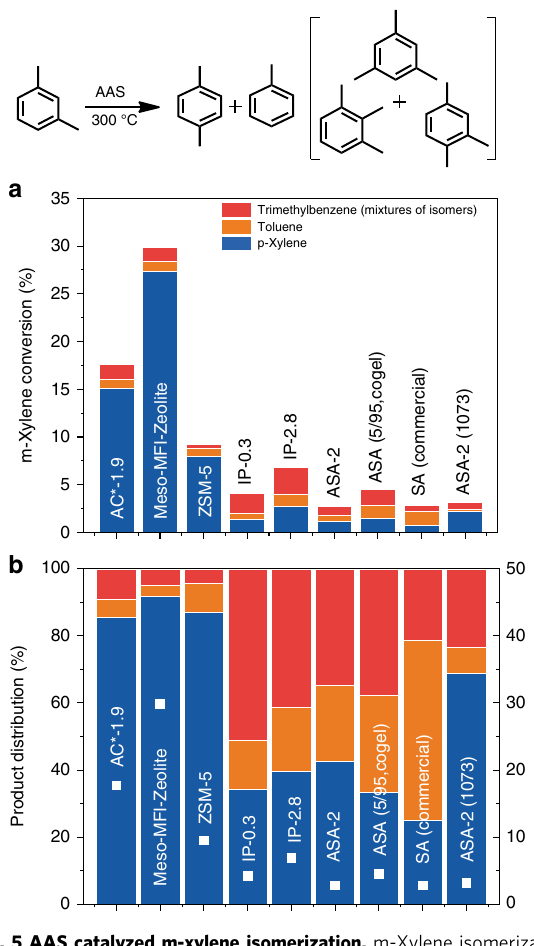
Fig. 5 AAS catalyzed m-xylene isomerization. m-Xylene isomerization reaction by solid acids, a m-xylene conversion and product yield, and b m- xylene conversion (white square) and product distribution. Error in the conversion is within